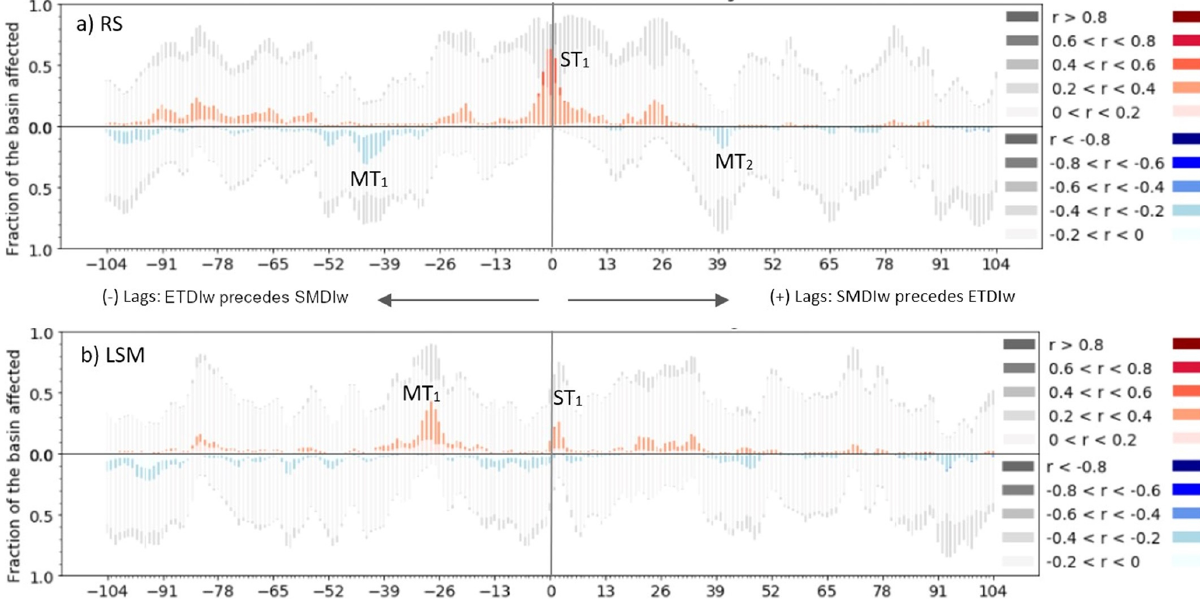
Figure 7. Lag plots of ETDIw–SMDIw at the weekly timescale in the period 2010–2017 for (a) RS data and (b) LSM data. Lags are calculated for the − 104 leading and for the + 104 lagged time steps of SMDIw in reference to ETDIw. The five levels of red and blue indicate the positive (red) or negative (blue) Pearson correlation coefficient between ETDIw and SMDIw for each time step (lead or lag time step). The height of the bars of the plot indicates the area of the basin affected by that level of r Pearson